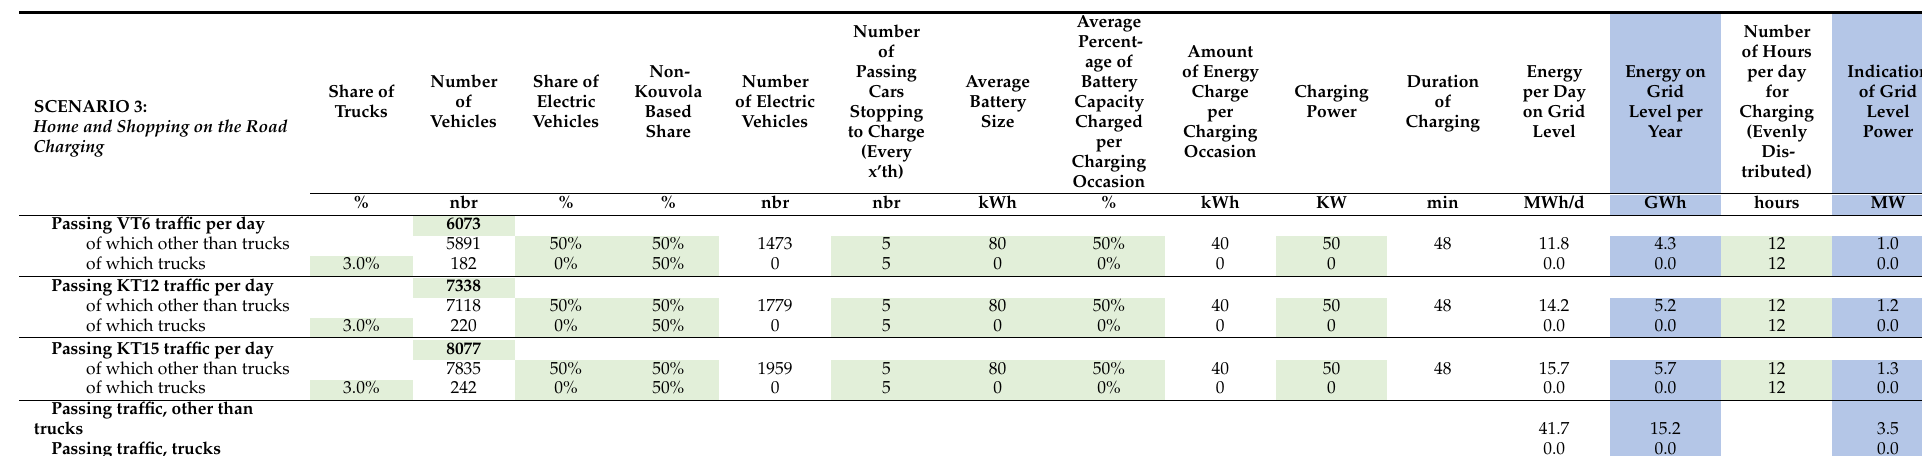
Table A9. Detailed quantification of passing traffic (the derived additional energy is consolidated into the summary (Table A7) and subdivided into user groups in Table